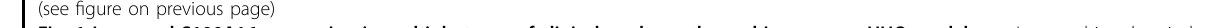
Fig. 1 Increased S100A16 expression in multiple types of clinical nephropathy and in a mouse UUO model. a – e Immunohistochemical staining of S100A16 in kidney biopsy specimens from patients with kidney disease. Scale bar = 50 μ m. f Semi-quantitative analysis of S100A16 protein expression levels. * p < 0.05, ** p < 0.01 com p ared with normal human kidneys. g Representative images for immunohistochemical staining of S100A16 in the obstructed kidneys of wild type mice, S100A16 Tg mice, and S100A16 + / − mice. Scale bar = 50 μ m. h , i Semi-quantitative analysis of S100A16 protein expression in S100A16 Tg and S100A16 + / − UUO kidneys compared with wild type sham groups. * p < 0.05, ** p < 0.01 compared with wild type sham groups; # p < 0.05. j , k Representative bands of western blots showing S100A16 protein abundance in obstructed transgenic murine kidneys. l , m Semi-quantitative analysis of S100A16 protein expression levels. * p < 0.05, ** p < 0.01 compared with a wild type sham groups; # p < 0.05, ## p <